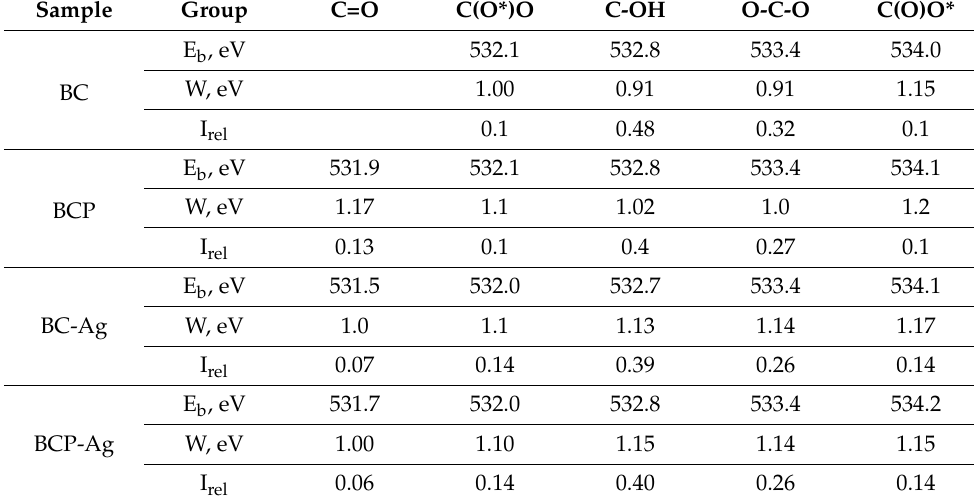
Table 4. Characteristics of the O 1s photoelectron spectra: binding energies (E b ), Gaussian widths (W) and relative intensities (I rel ) of photoelectron peaks belonging to different chemical groups. Sample